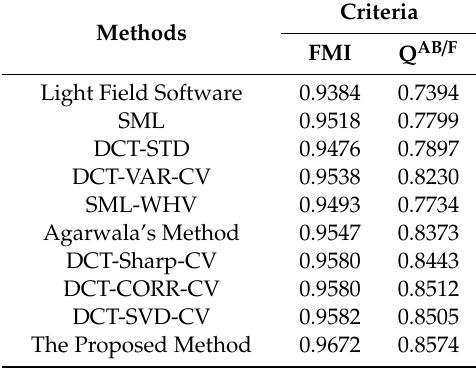
Figure 14. Comparison of ‘Bike’ image results: ( a ) Light Field Software, ( b ) SML, ( c ) DCT-STD, ( d ) DCT-VAR-CV, ( e ) SML-WHV, ( f ) Agarwala’s method, ( g ) DCT-Sharp-CV, ( h ) DCT-CORR-CV, ( i ) DCT-SVD-CV, ( j ) The Proposed Method. Table 3. Objective evaluation of the image results (non-reference fusion metrics) for ‘Bike’ image.